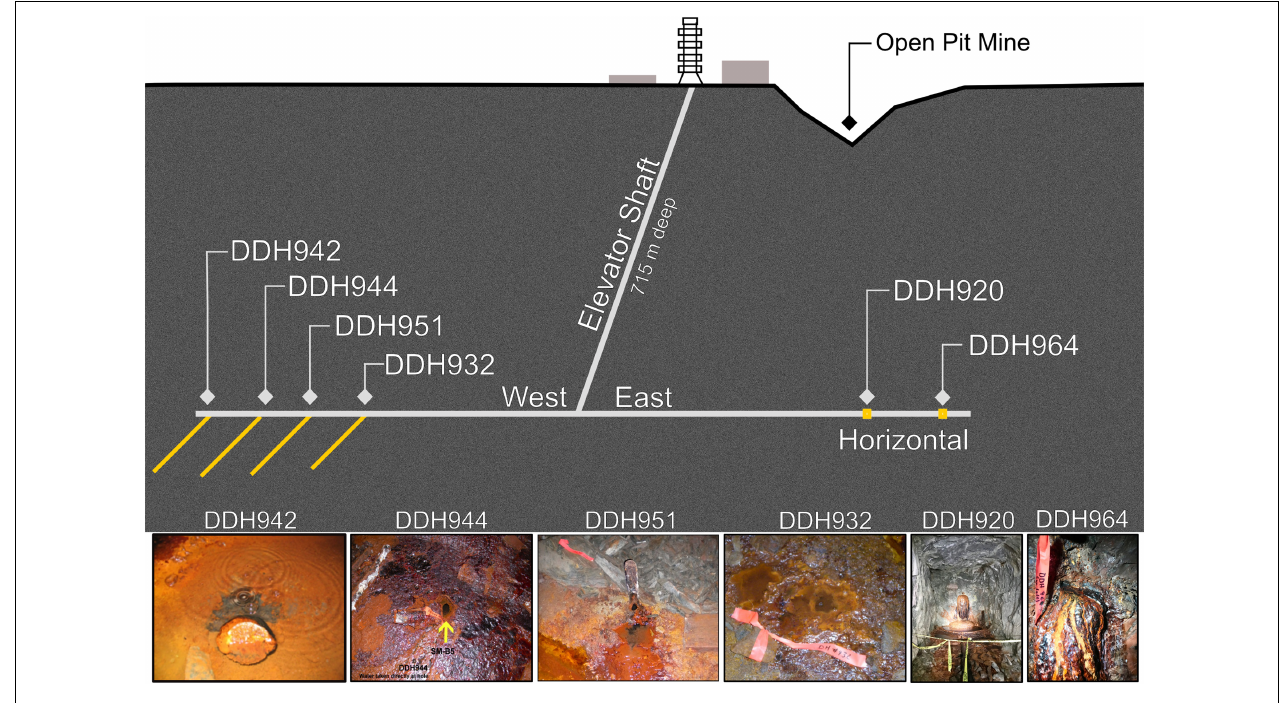
FIGURE 1 | Overview and layout of the legacy boreholes sampled at the Soudan Underground Iron